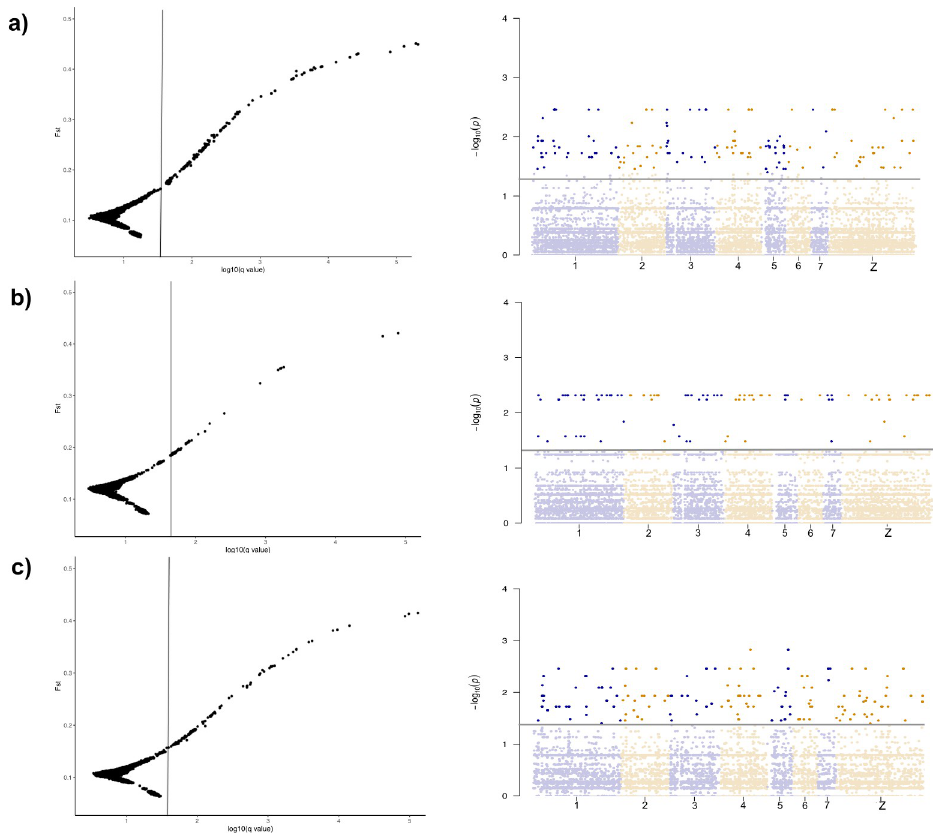
Fig 4. Plot of F st outliers and genome scan of all identified loci that match to the indexed S . mansoni genome. On the left F st values obtained from BAYESCAN, each plot figure represents outliers in each simulated comparison: A) S . haematobium x S . bovis , B) S . haematobium x S . guineensis , C) S . guineensis x S . bovis . Loci that fall to the right of the vertical line have a probability greater than 50% of being designated outlier loci. Genome scan plots on the right show genomic location of outlier loci across the